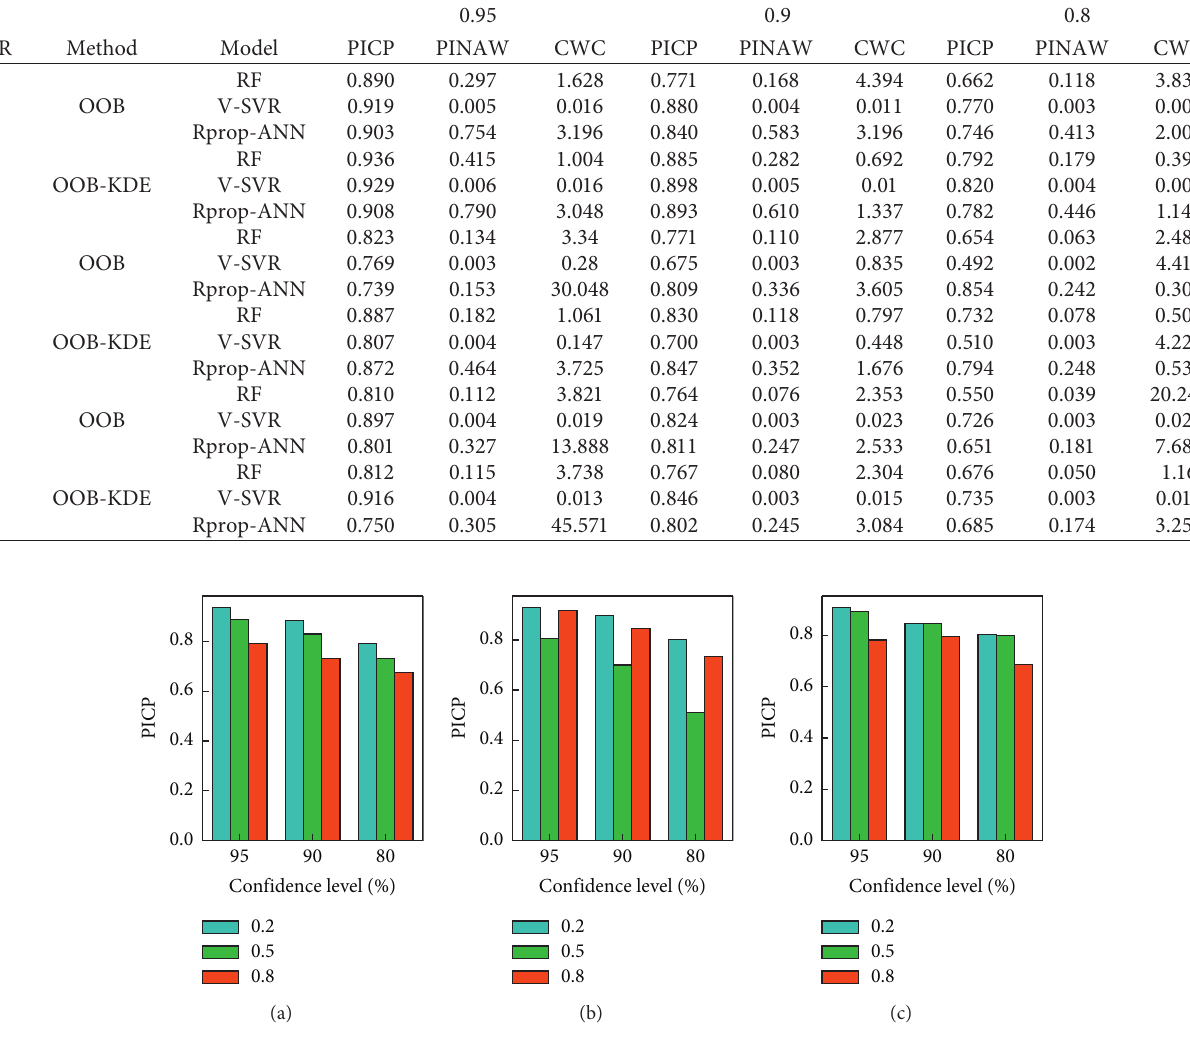
Figure 8: Histogram of PICP for all prediction models.